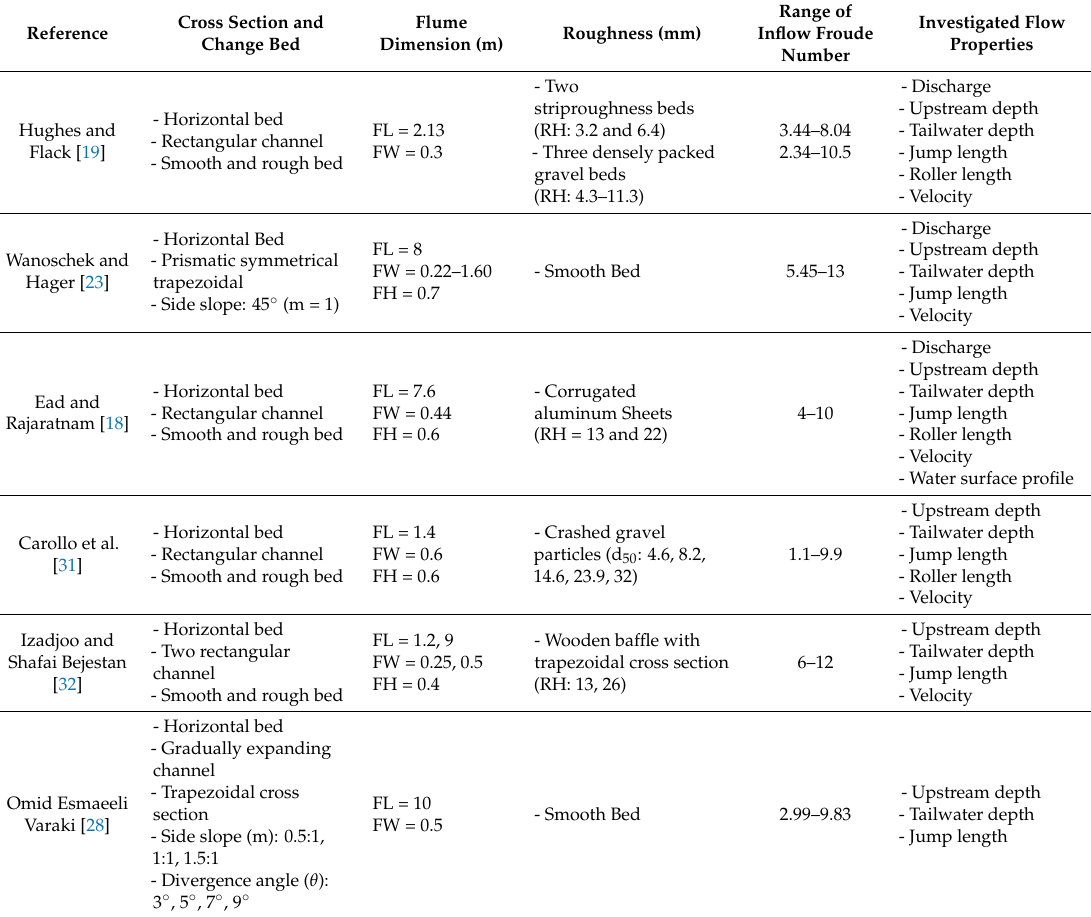
Table 1. Past experimental studies on hydraulic